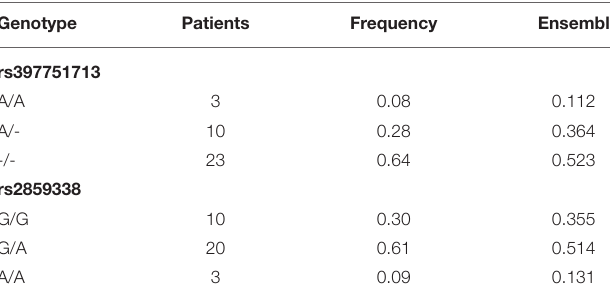
TABLE 1 | Frequencies of the SNPs detected in EDN1 UTRs in our cohort and ensemble.